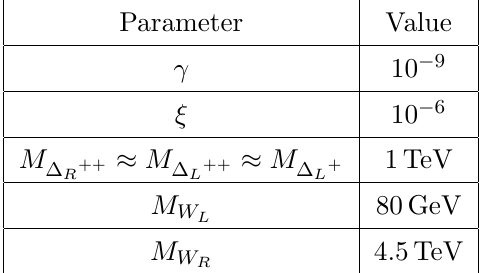
Table 4 . The numerical values of di(cid:11)erent parameters in minimal LRSM adopted in our numerical